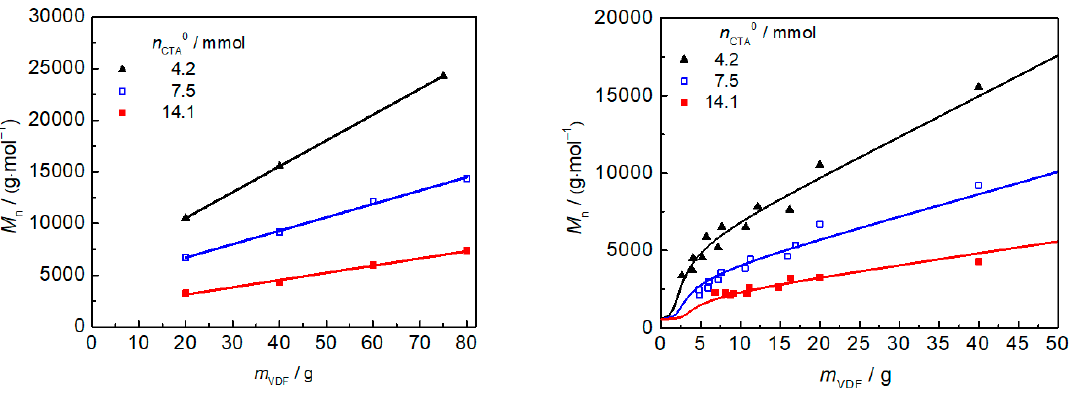
Figure 2. Evolution of number average molar masses with mass of VDF consumed for reactions at 75 °C and 20 bar with C 4 F 8 I 2 amounts as indicated. n CTA0 is the effective amount of CTA available for chain transfer.